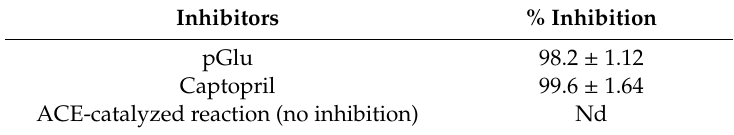
Table 2. Inhibitory effects of pyroglutamic acid and captopril on the human angiotensin-converting